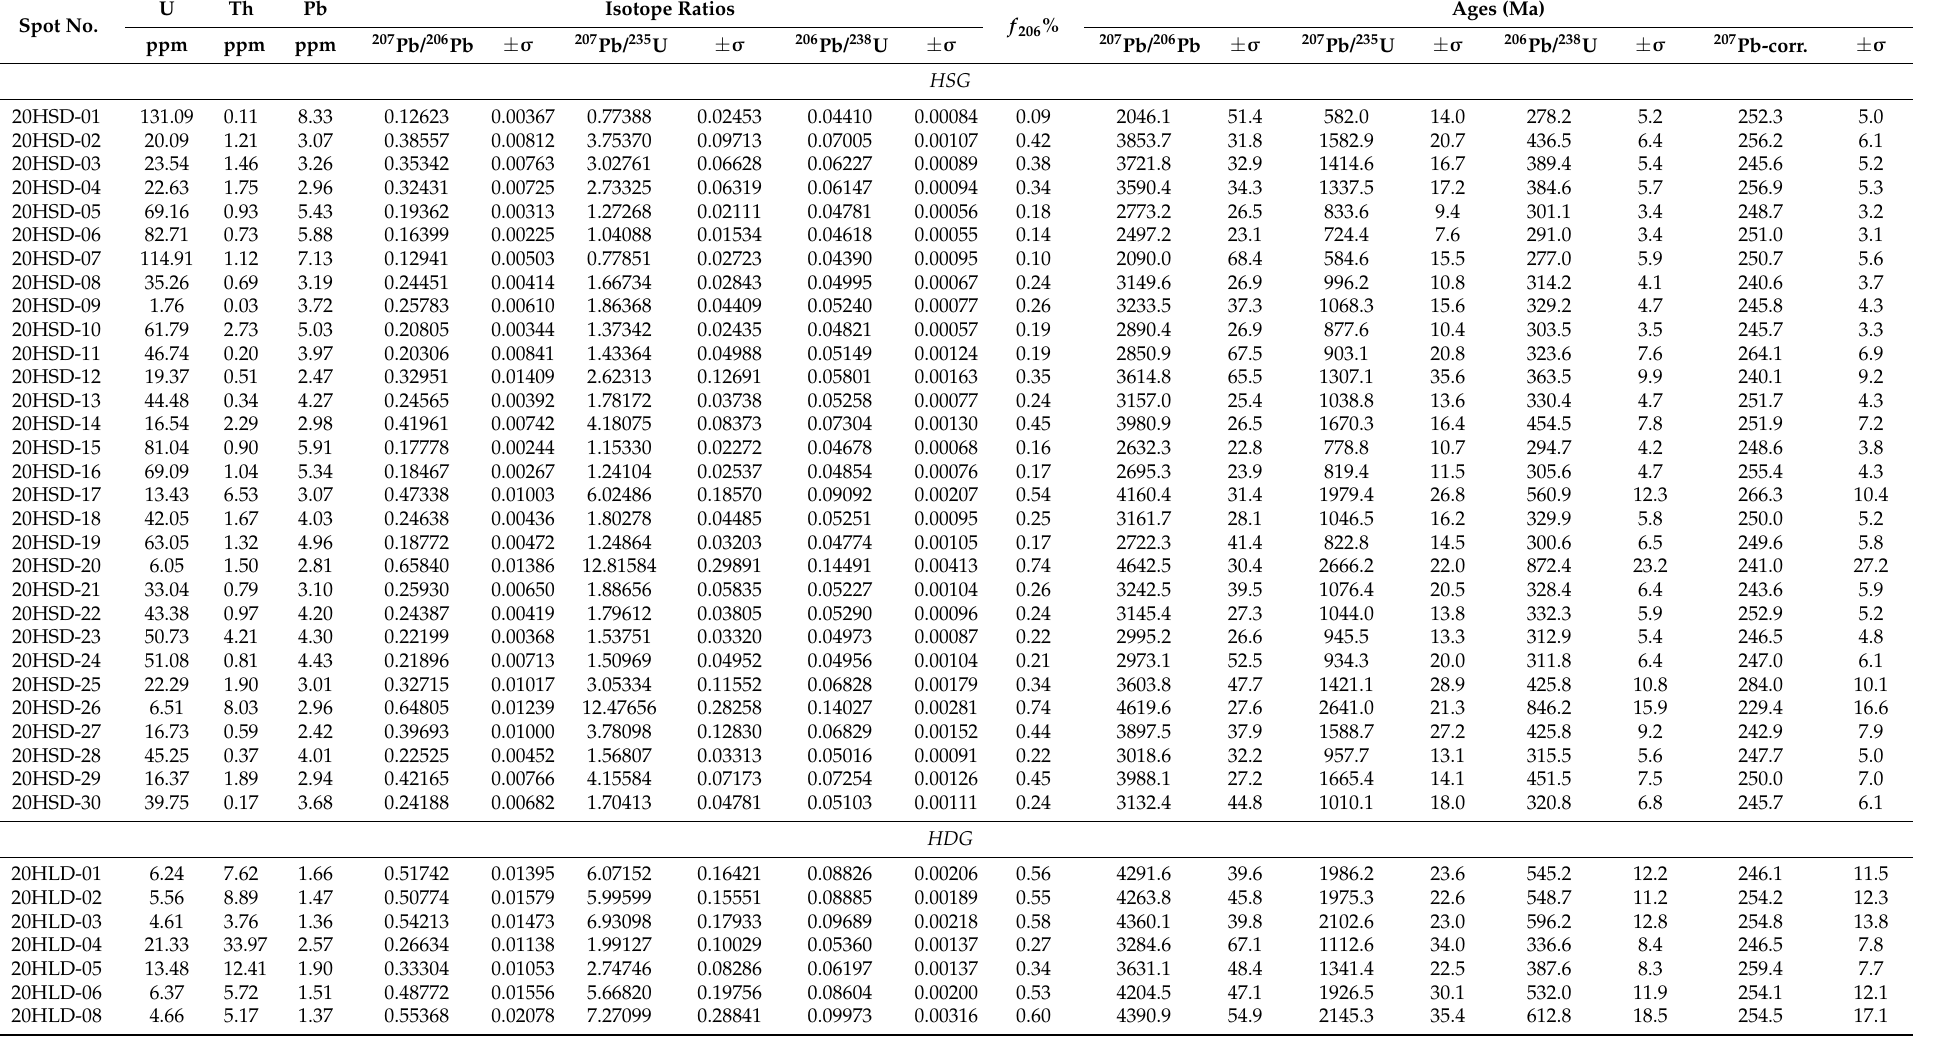
Table 2. LA-ICP-MS U-Th-Pb data of apatite grains from HSG and HDG of the